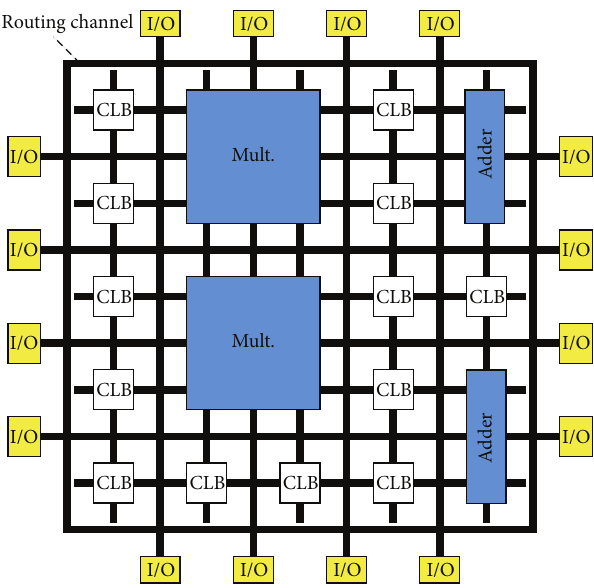
Figure 3: Generalized example of the FPGA architecture.